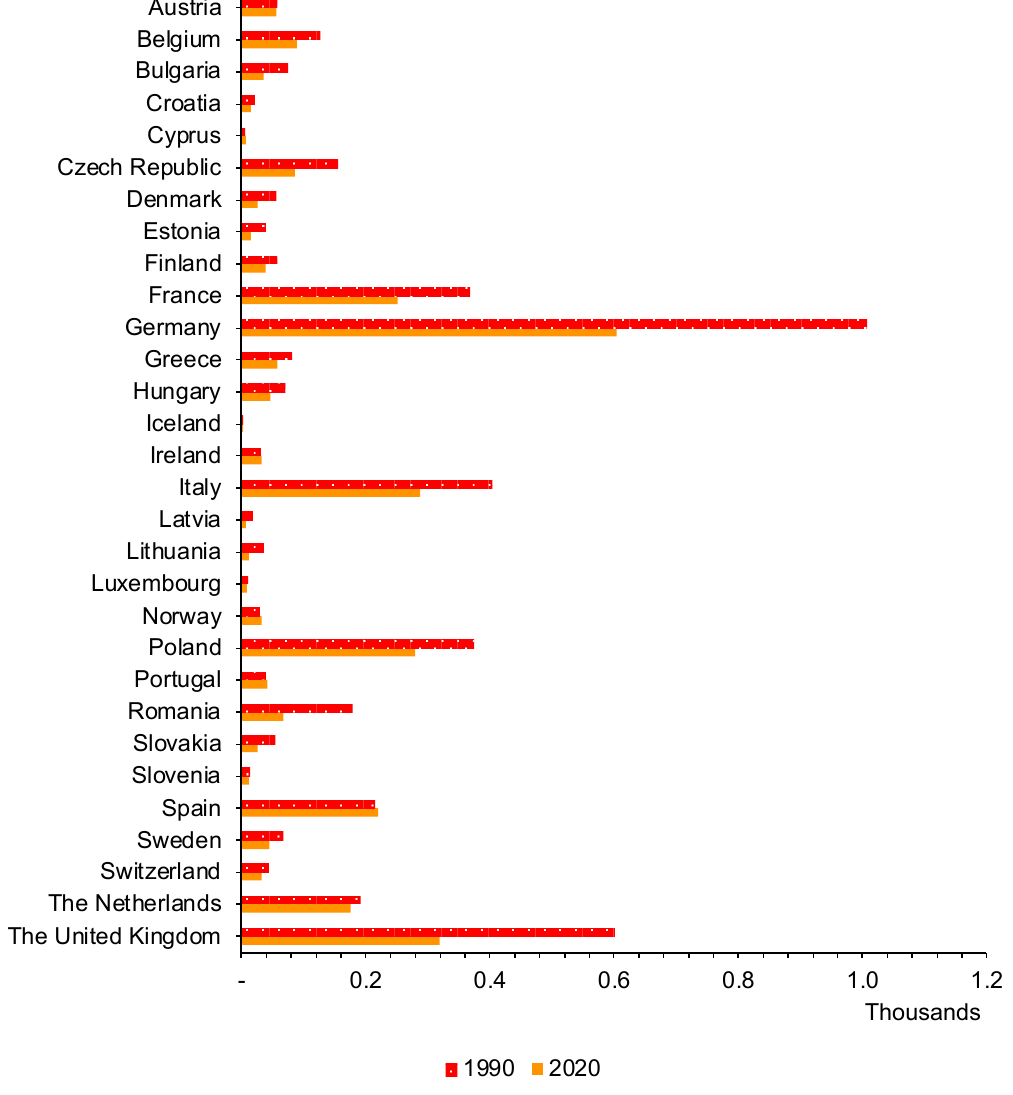
Figure 2. CO 2 emissions in millions of tonnes per capita in the 27 EU countries + Norway and the United Kingdom in 1990 and 2020. The authors created this figure with BP Statistical Review of World Energy data [5].